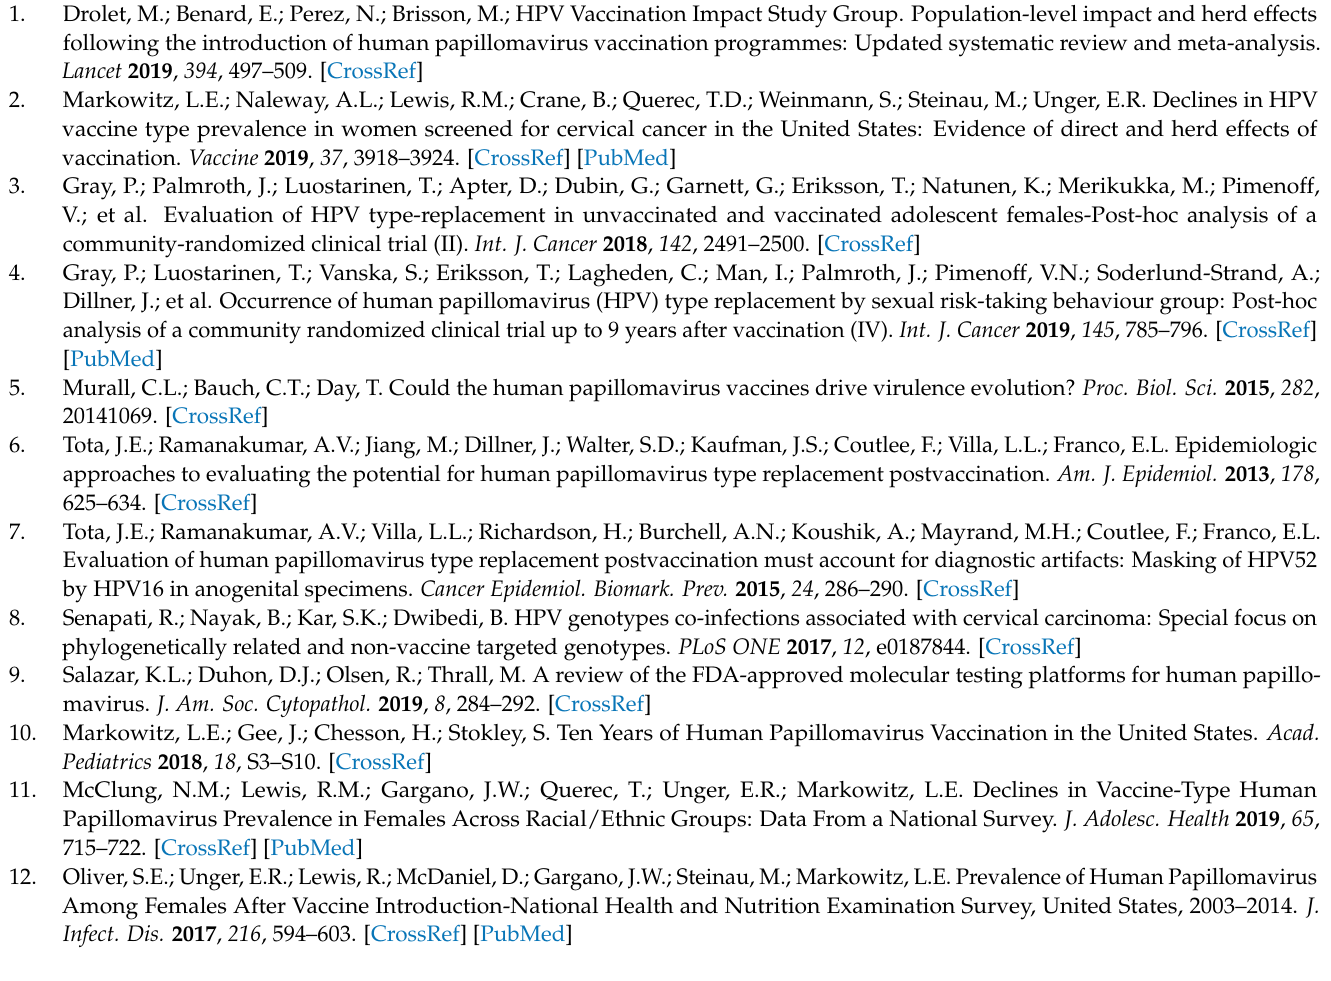
Table S8: Type-specific concordance of HPV CodeSets in comparison to LA or TypeSeq (Z-test results) under different testing and sample